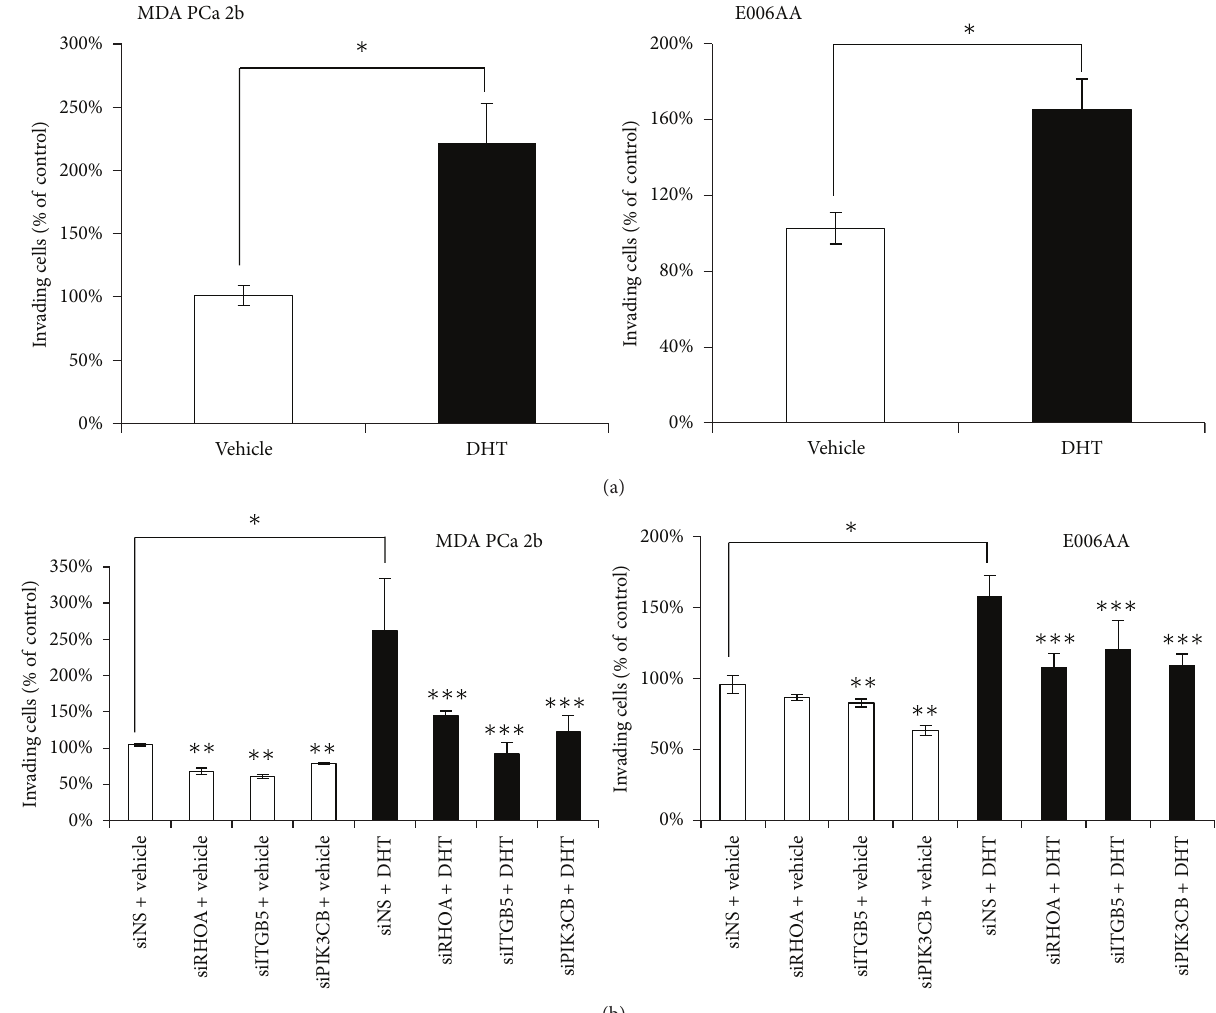
(b) F 5: AR-target genes promote cell invasion in an androgen-dependent manner in AA cancer cells. (a) Androgen stimulation (10nM DHT for 48hr) increases invasion in the AA PCa cell lines MDA PCa 2b and E006AA. (b) siRNA-mediated knockdown of AR-target genes RHOA, ITGB5, or PIK3CD diminished androgen-induced (10nM DHT for 48hr) cell invasion in both MDA PCa 2b and E006AA cell lines. Knockdown efficiency (determined for each experiment) was typically 80 as determined by qRT-PCR (data not shown). Data are Signi�cant difference between cells treated with vehicle ( 0.01 represented as the mean SEM of 4–7 independent cell invasion assays. Signi�cant difference between ethanol �nal concentration) versus 10nM DHT using an ANOVA with Holm post hoc test ( ). ∼ % ∗ vehicle-treated cells incubated with siRNA against RHOA , ITGB5 , or PIK3CB versus vehicle-treated cells incubated with nonsense siRNA < % ± ∗∗ Signi�cant difference between DHT-stimulated cells incubated with siRNA (siNS) using an ANOVA with Holm post hoc test ( ). 𝑃𝑃 < 𝑃𝑃𝑃𝑃 against RHOA , ITGB5 , or PIK3CB versus DHT-stimulated cells incubated with nonsense siRNA (siNS) using an ANOVA with Holm post ∗∗∗ hoc test ( 𝑃𝑃 < 𝑃𝑃𝑃𝑃 𝑃𝑃 < 𝑃𝑃𝑃𝑃